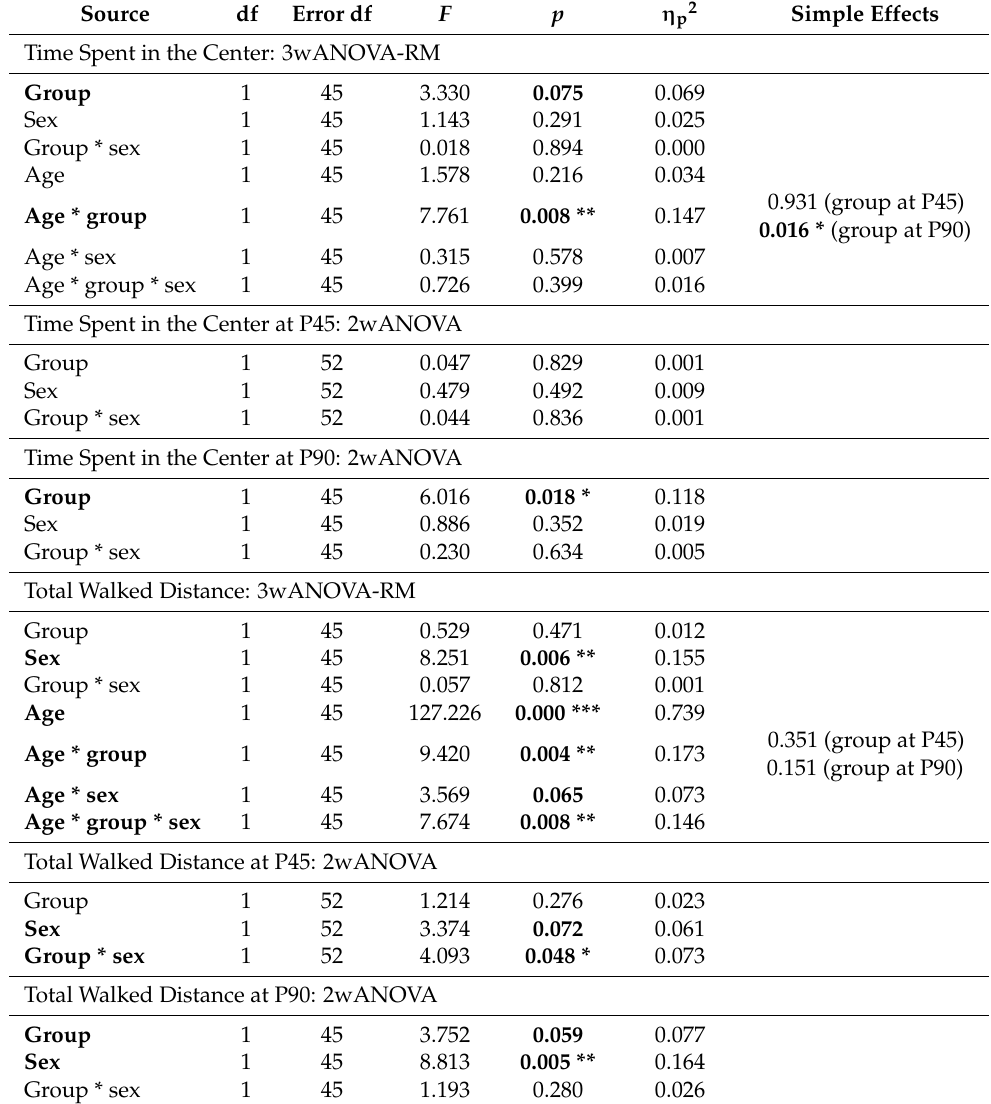
Table A7. Three-way ANOVA-RM and two-way ANOVA table for the open field test. Source Simple Effects